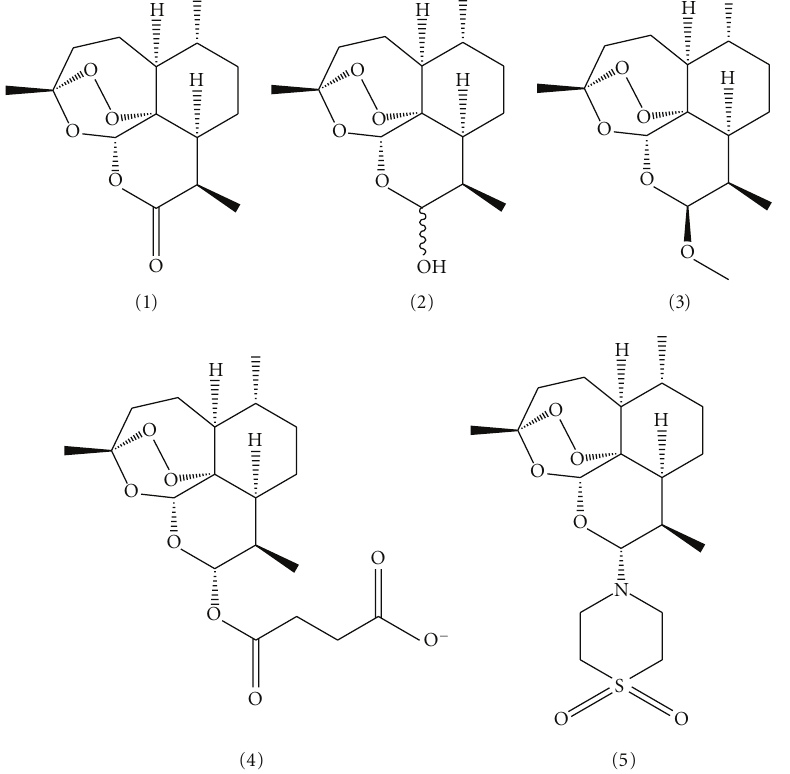
Figure 1: Chemical structure of artemisinin antimalarials (artemisinins) with anticancer activity. Artemisinin (1), dihydroartemisinin (DHA) (2), artemether (3), artesunate (4), and artemisone